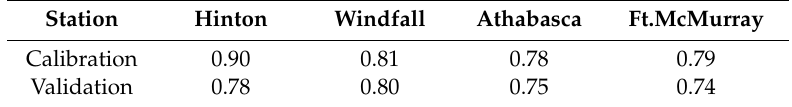
Table 2. The VIC hydrologic model performances in terms of the Nash–Sutcliffe values during the calibration (1985 − 1997) and validation (1998 − 2010) periods.